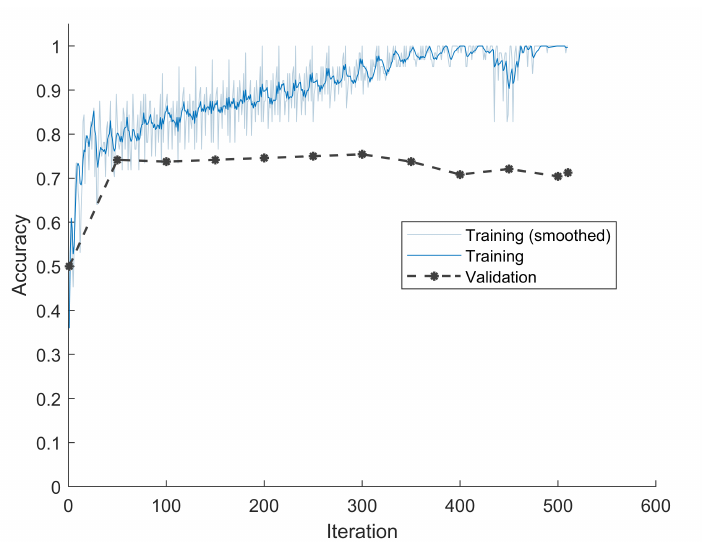
Figure 8. Classification accuracies and loss during training and validation for DC values after VLC. The average performance denotes that VLC devastated the correlation between pixels and bitstream.